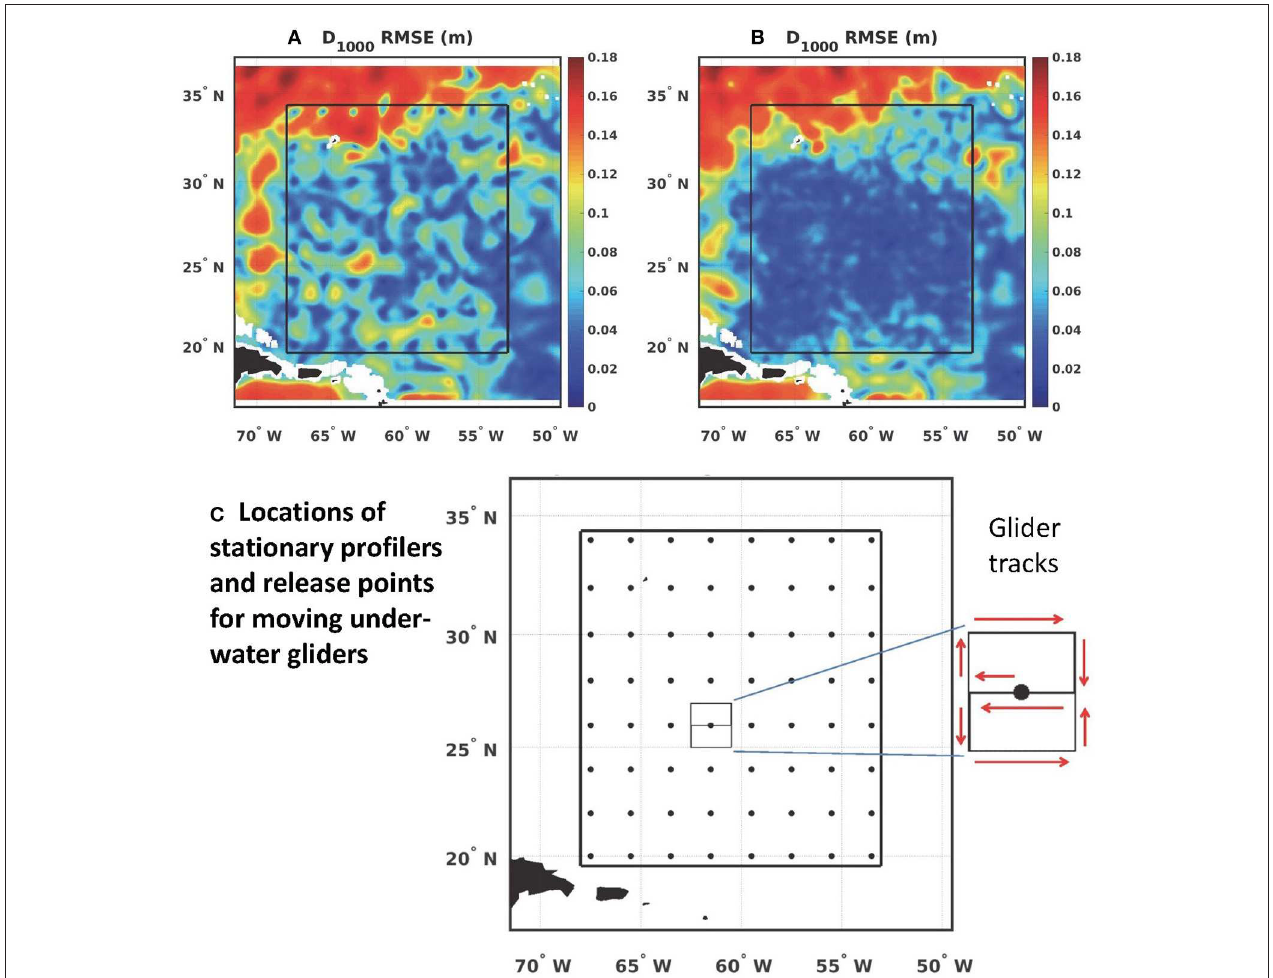
FIGURE 5 | Maps of RMS error in dynamic height at the surface relative to 1,000m for (A) the stationary profiler experiment, and (B) the moving glider experiment, calculated over the time interval from July to October 2014. Stationary profilers and gliders were released at longitude-latitude grid points shown in (C) with separation distances of 2.0 ◦ . All gliders released at these same points executed a reverse figure eight pattern over a track spanning 2 ◦ longitude and latitude while traveling at a speed of 0.25 ms − 2 . Both stationary and moving platforms sample temperature and salinity profiles to 1,000m depth. The experiments are conducted with